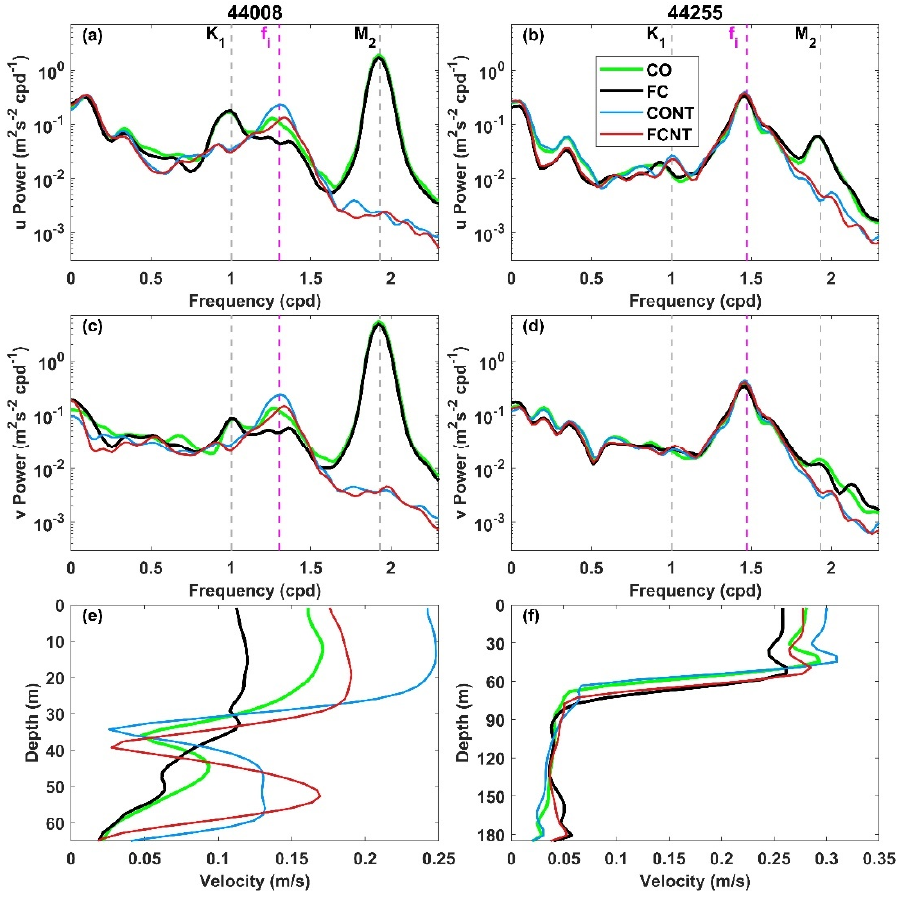
Figure 12. Power spectra of time series of ( a , b ) zonal and ( c , d ) meridional surface currents at buoys 44008 (left column) and 44255 (right column) in runs CO, FC, CONT, and FCNT. The dashed lines show the tidal frequencies (K 1 and M 2 ) and inertial frequency ( f i ). ( e , f ) Profiles of the averaged magnitudes of NIOs at these two stations during the post-storm period (6–12